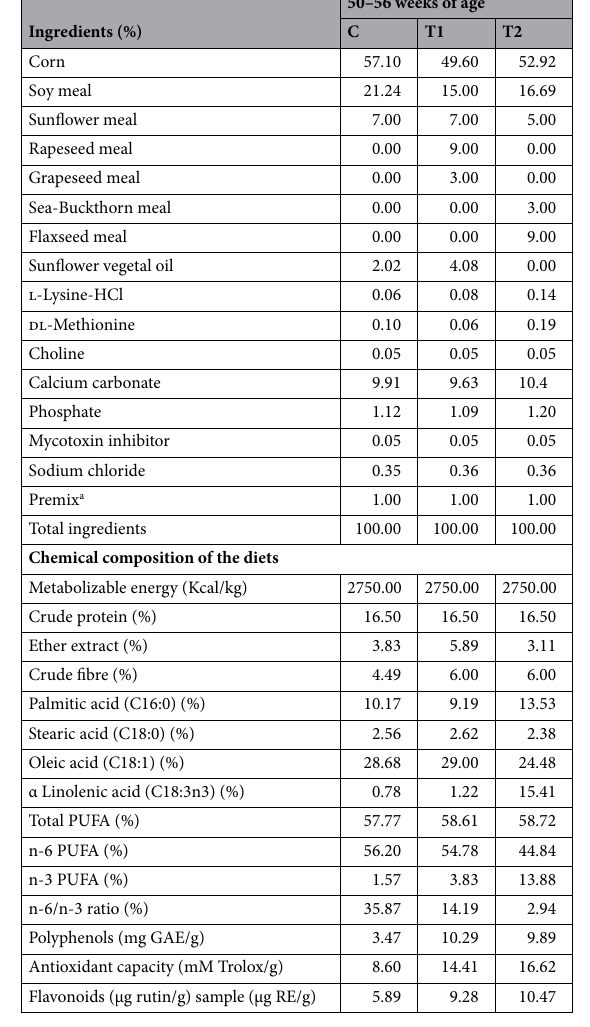
Table 6. Ingredients and chemical composition of the diets. C control diet, T1 control diet with 9% rapeseed meal and 3% grapeseed meal, T2 control diet with 9% flaxseed meal and 3% sea-buckthorn meal, PUFA polyunsaturated fatty acids. a The premix provided the following per kilogram of diet: vitamin A:13.500 IU; vitamin D3:3.000 IU; vitamin E:27 mg; vitamin K3: 2 mg; vitamin B1: 2 mg; vitamin B2: 4.8 mg; pantothenic acid: 14.85 mg; nicotinic acid: 27 mg; vitamin B6: 3 mg; vitamin B7: 0.04 mg; vitamin B9:1 mg; vitamin